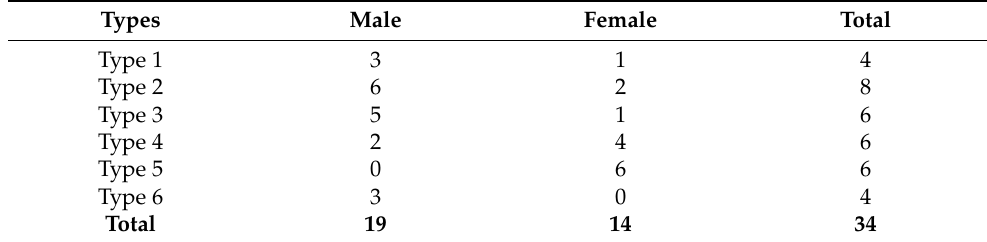
Table 2. Composition of focus group members.